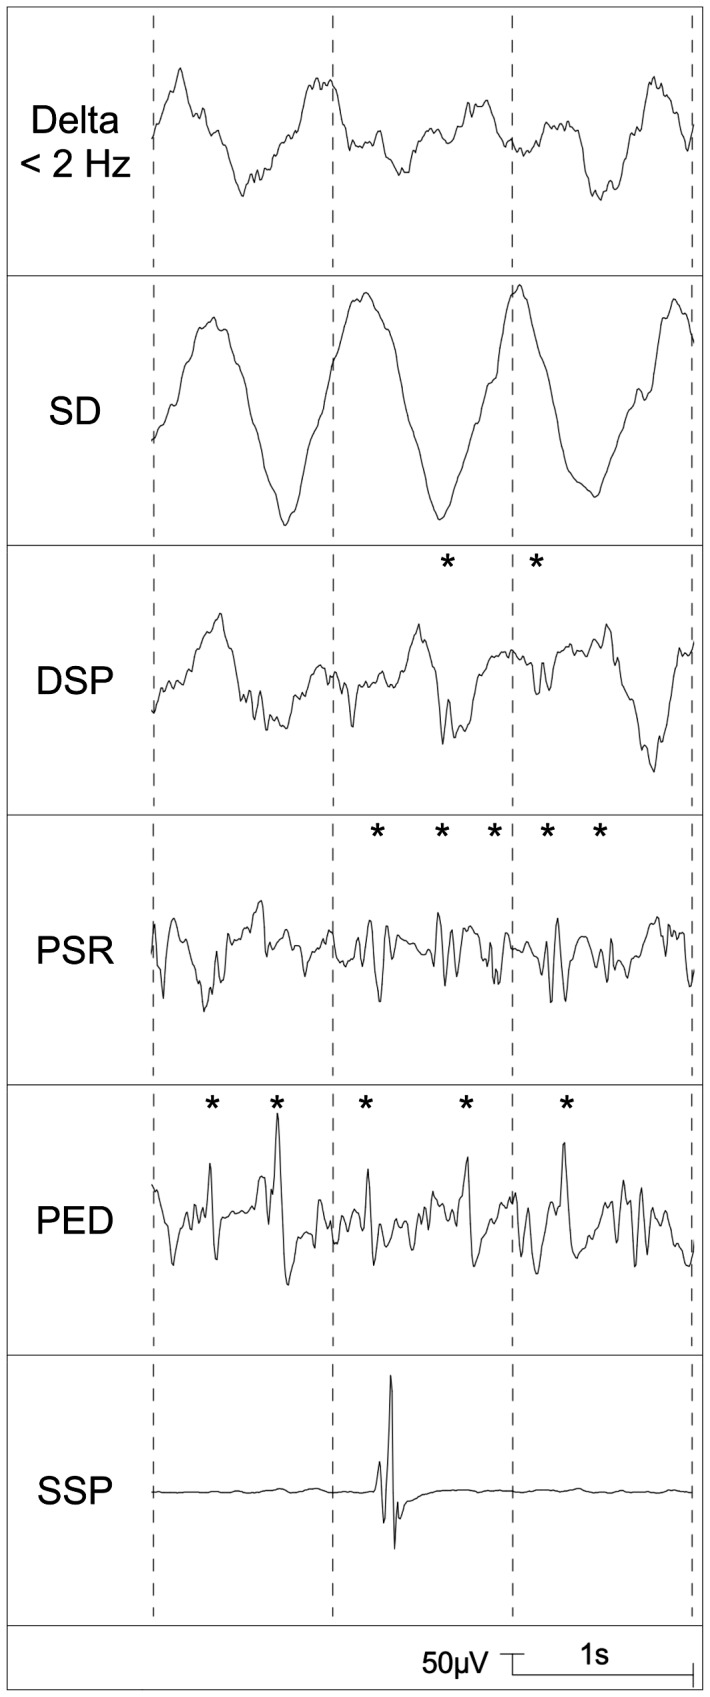
Typical examples for the EEG patterns delta <2 Hz, slow delta (SD), delta with spikes (DSP), rhythmic polyspikes (PSR), periodic epileptiform discharges (PED), and suppression with spikes (SSP).